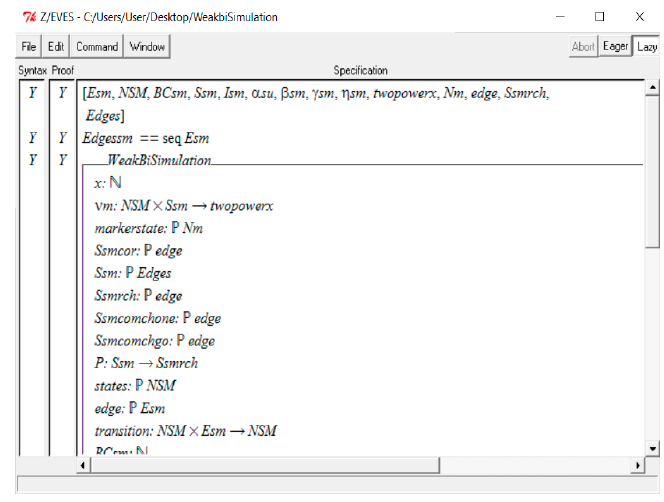
Figure A2. The snapshot of the formal specification analysis of machine model.